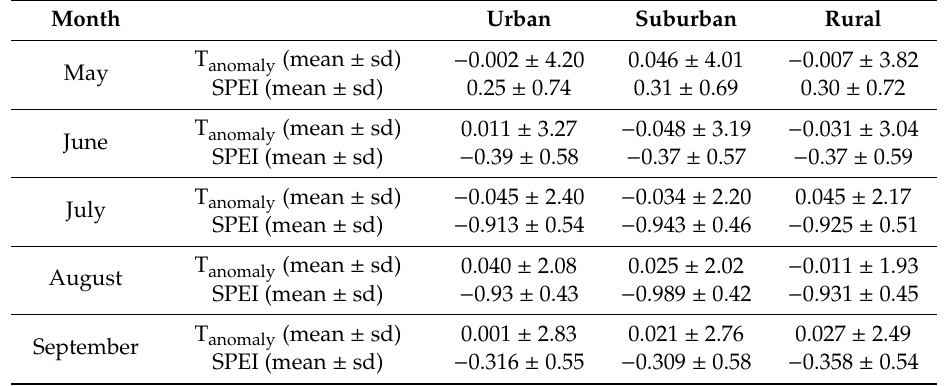
Table 4. Monthly mean and standard deviation (sd) values of SPEI and temperature anomalies (T anomaly ) for urban, suburban, and rural